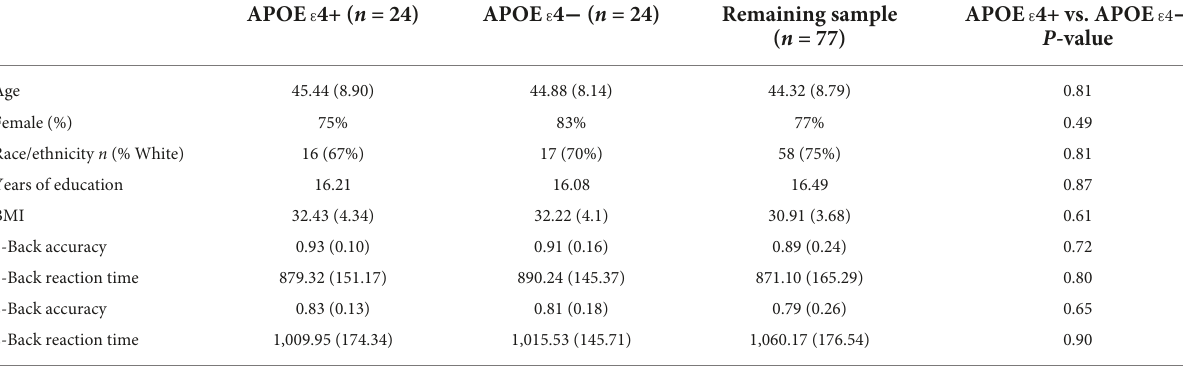
TABLE 1 Demographic and n-back performance data for participants.